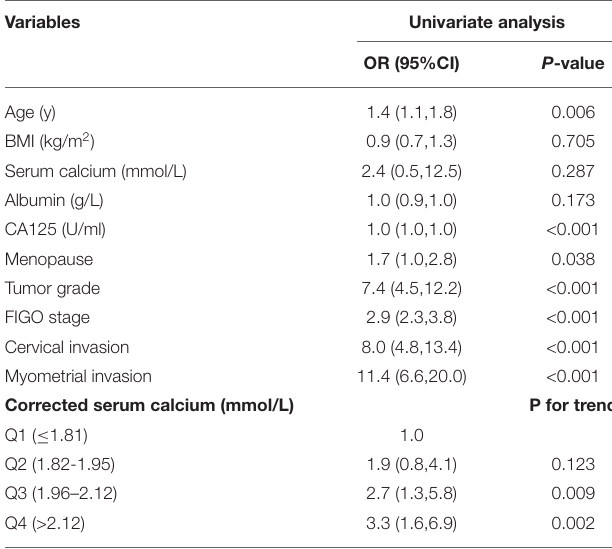
TABLE 2 | Univariate logistic regression analysis of in EC